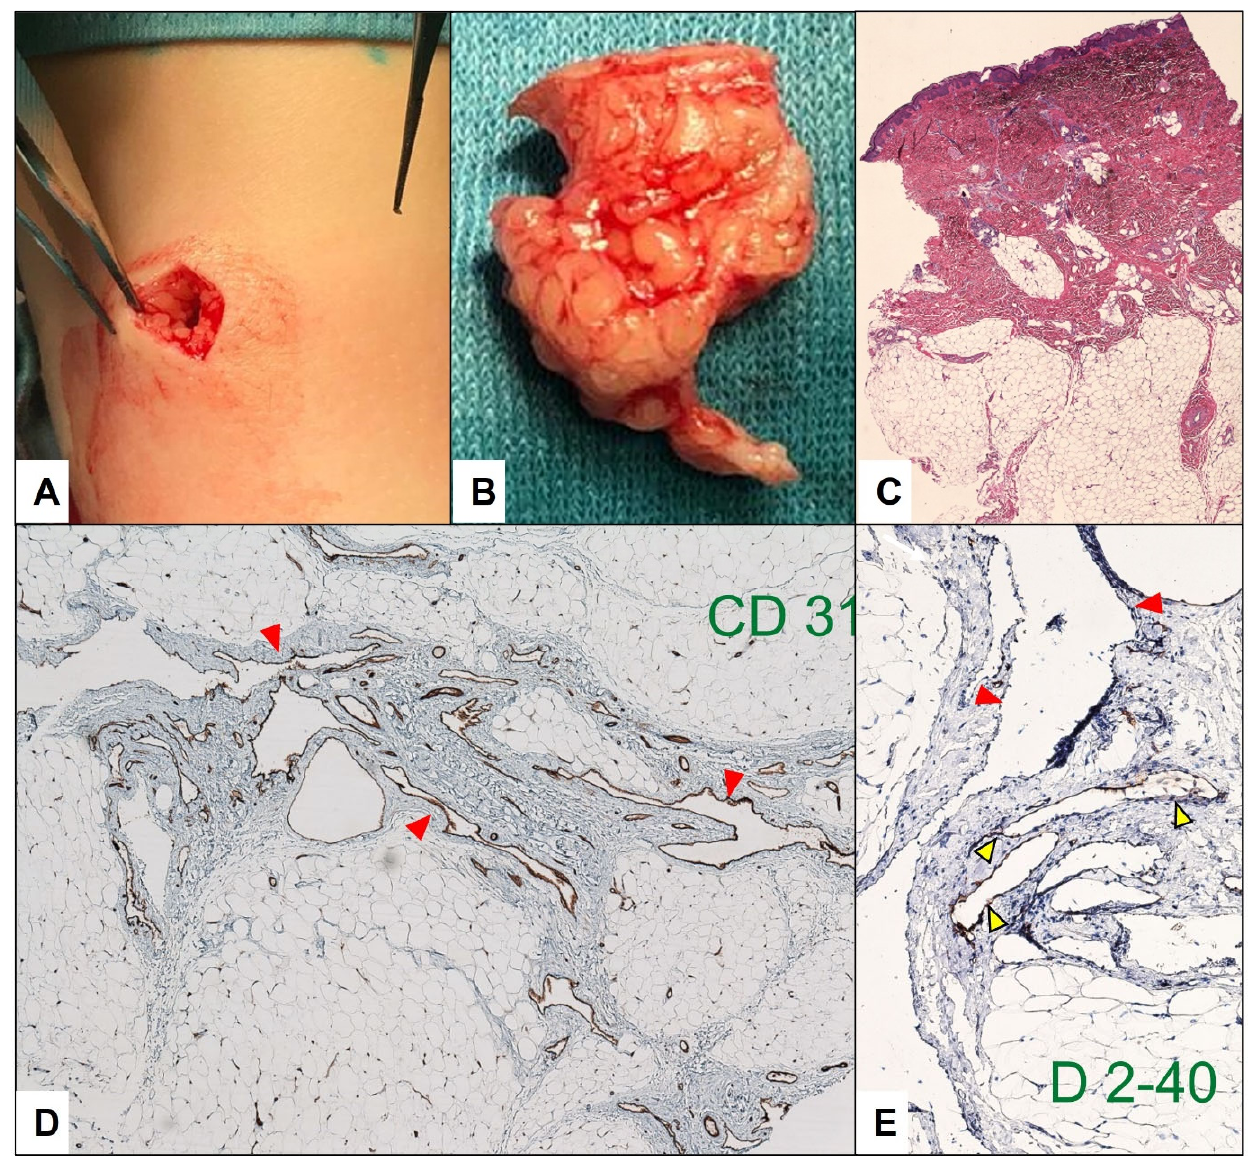
Figure 8. The patient from Figure 7 underwent an incisional biopsy of the pretibial lesion at 15 months of age ( A , B ). The H&E staining showed no granulomatous tissue in specimen ( C ). Immunohistochemistry showed irregular, dilated vascular structures surrounded by fat tissue in the deep subcutaneous tissue layer, which strongly expressed the CD31 vascular marker ( D )—(red arrowheads). D2-40 ( E ) stains positive in the lymphatic component (yellow arrowheads) and is negative in the endothelial cells of the veins (red arrowheads).